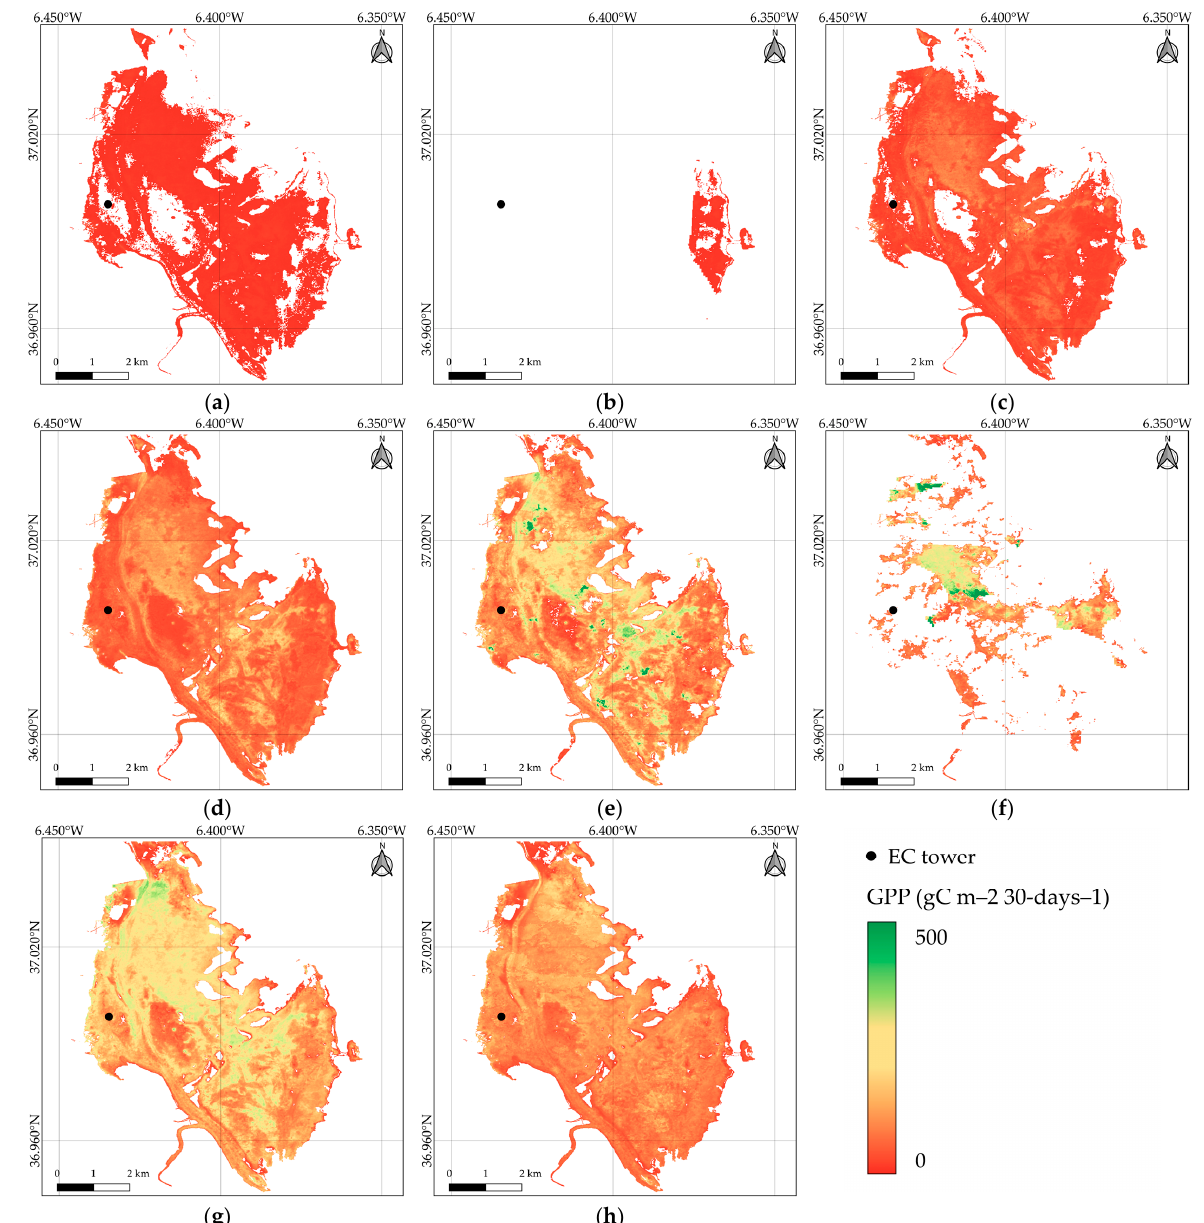
Figure 15. 15-days GPP maps. The maps show the spatial and temporal pattern of GPP (gC m − 2 15-days − 1 ). ( a ) 1–15 February 2021, ( b ) 16–28 February 2021, ( c ) 1–15 March 2021, ( d ) 16–31 March 2021, ( e ) 1–15 April 2021, ( f ) 16–30 April 2021, ( g ) 1–15 May 2021, ( h ) 16–31 May 2021. The production of maps using 15-day composite images was affected by the high cloud coverage over the study area. This phenomenon can be clearly observed in the maps produced for the second half of February and April 2021. This hampered the estimation of GPP for the considered time range. The 15-day composite image, however, also allowed for better identification of the flooded period. This was the case for the month of January 2021. Comparing the first and second half of the month, we can observe that some pixels